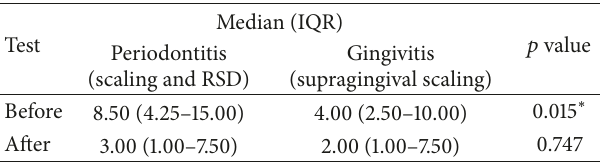
Table 4: Association between the groups of OHIP-14 item score before and after NSPT † .